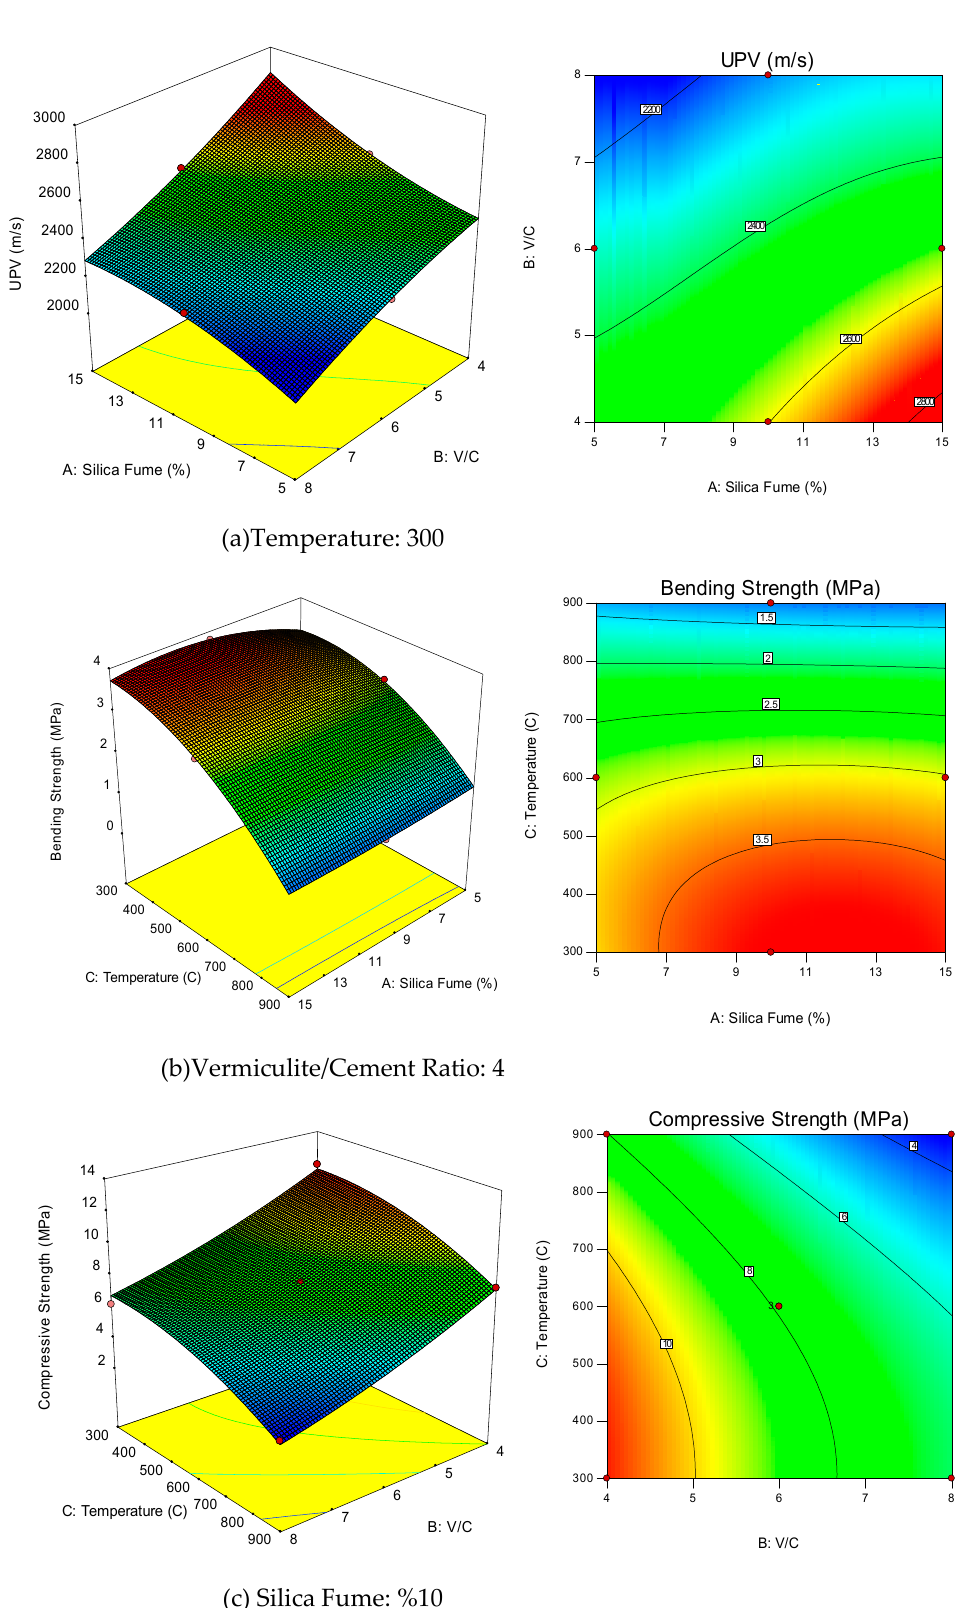
Figure 4. Influence of independent variables and their interactions on response variables. Simultaneously multi-objective optimization is the determination of the proportions of independent variables that can be used to obtain an optimized mortar mix based on the